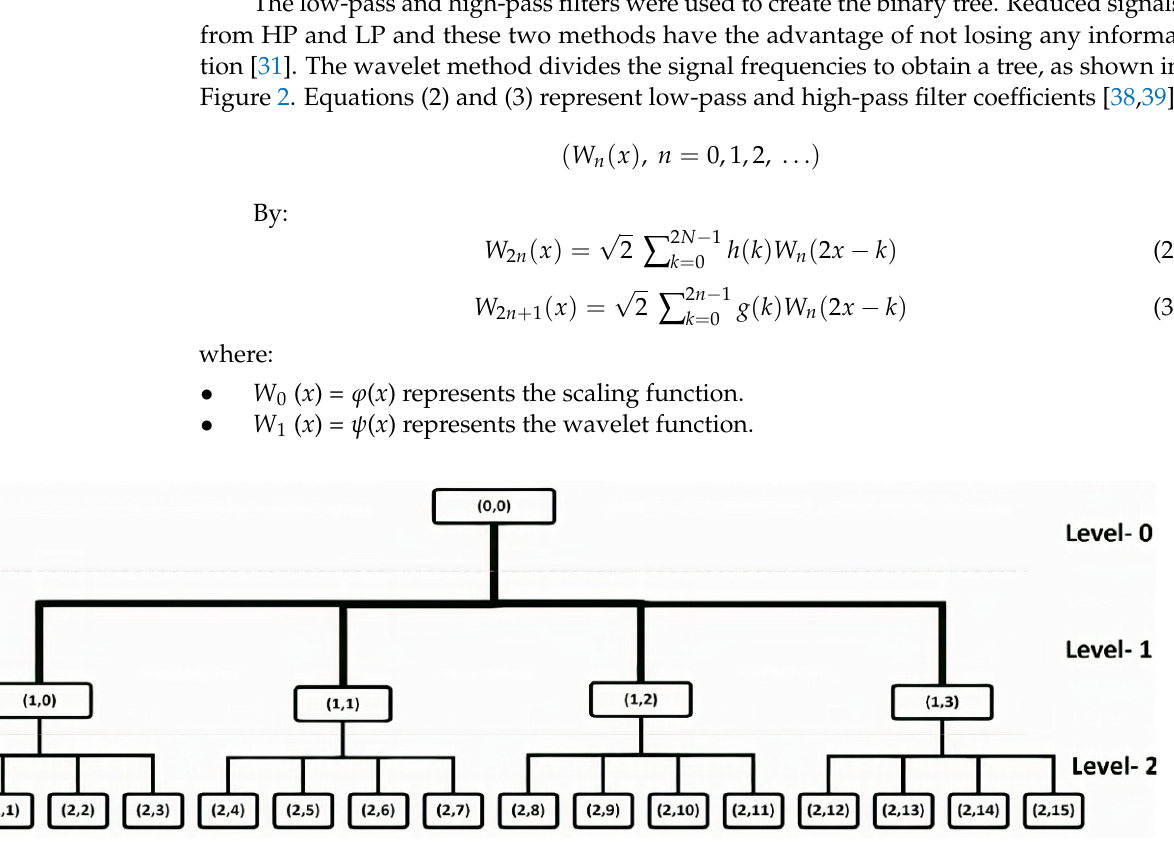
Figure 2. Wavelet Packet Decomposition Tree.